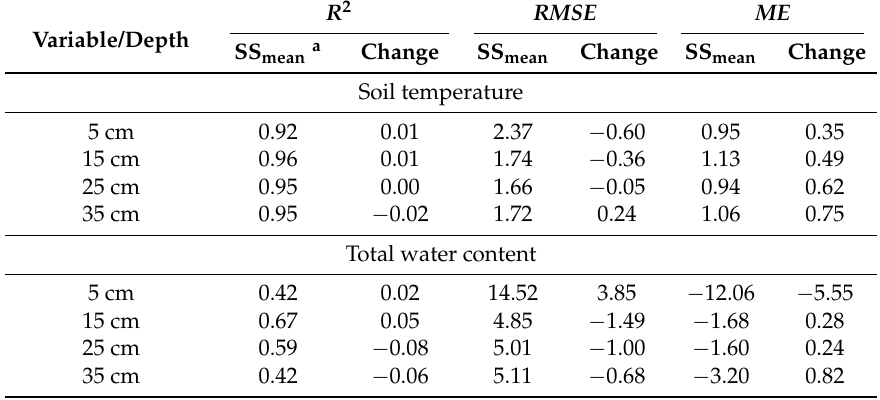
Table 5. Comparison of performance indices for single simulation with mean value of parameters with mean performance indices for behavioral models. R 2 RMSE ME SS mean